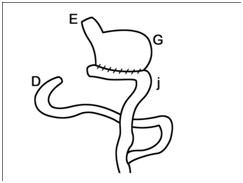
Roux-en-Y procedure.